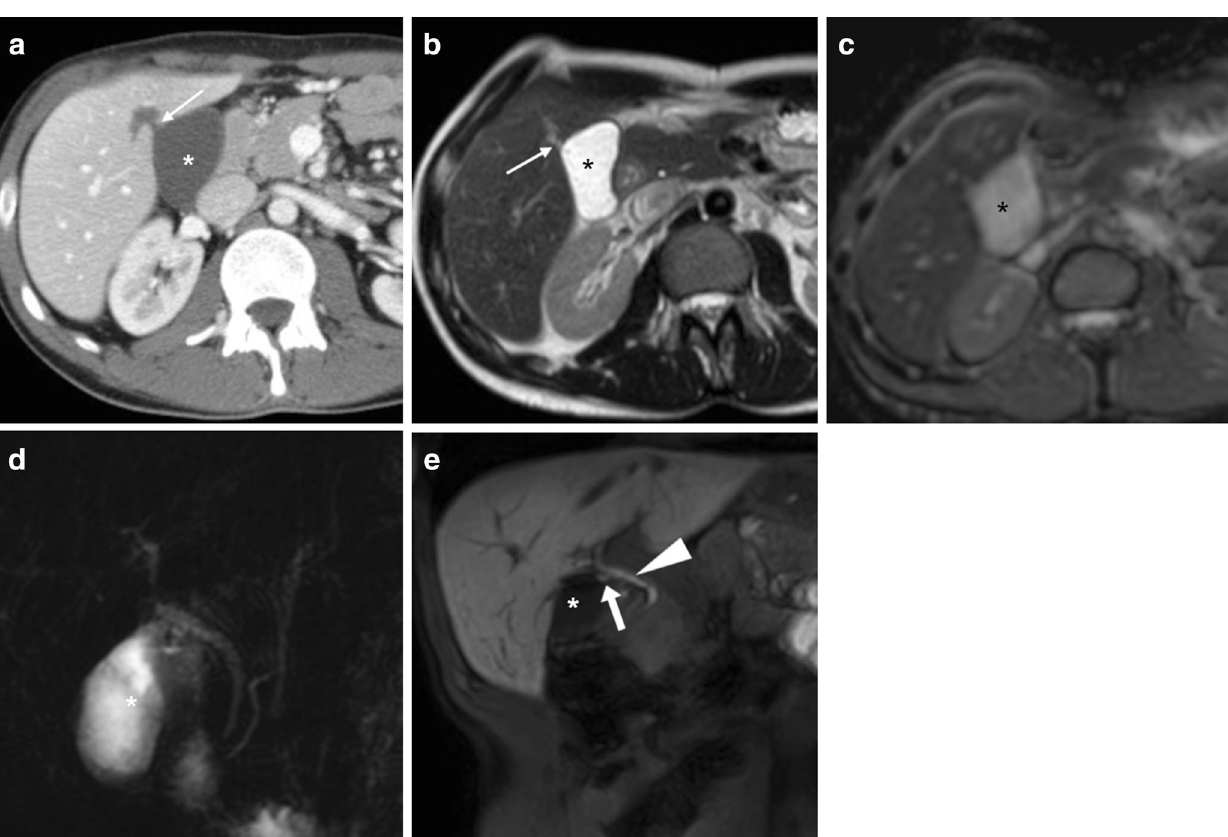
Fig. 9 Typical biloma (*) observed 2 weeks after laparoscopic cholecystectomy as water-attenuation collection abutting the gallbladder fossa at CT ( a ). Some days later, MRI showed unchanged shape and size of the biloma, with homogeneous fluid and unrestricted diffusion on T2- weighted ( b ), apparent diffusion coefficient map ( c ) and MRCP ( d ). A